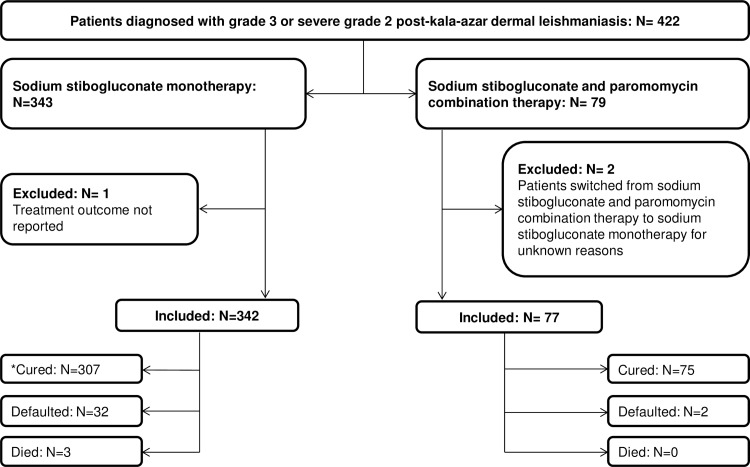
Flow diagram showing the number of patients in the study and their outcomes.* Treatment duration was not reported in one patient. This patient was excluded from the analysis on treatment duration.